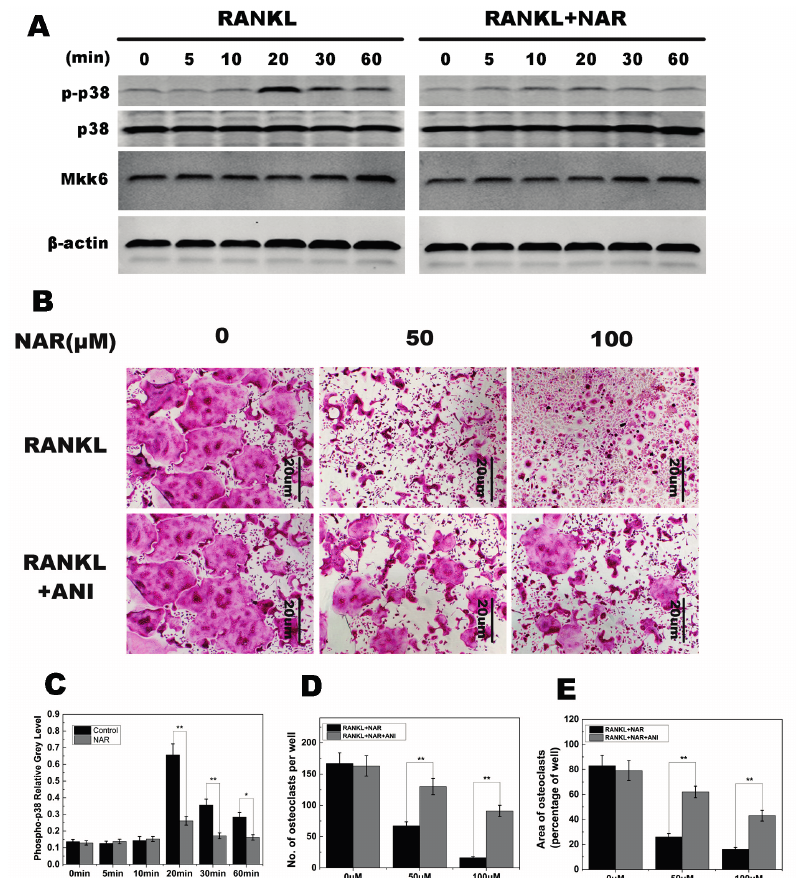
Figure 6. Naringenin (NAR)-mediated suppression of receptor activator of the nuclear factor- κ B ligand (RANKL)-induced effects on p38 signaling. ( A ) p38 phosphorylation was increased within 20–60 min of stimulation with RANKL in the control group, and greatly reduced by treatment with 200 μ M NAR. MAPK kinase 6 (MKK6) was not affected by 200 μ M NAR; ( B ) Anisomycin (ANI) counteracted the inhibitory effect of NAR on osteoclast formation. BMMs were stimulated with 30 ng/mL macrophage colony-stimulating factor (M-CSF), 50 ng/mL RANKL, and the indicated concentrations of NAR. In the rescue groups, cells were also treated with 2.5 ng/mL anisomycin. All treated cells were stained for tartrate-resistant acid phosphatase (TRAP); ( C ) The gray levels corresponding to p38 phosphorylation were quantified and normalized relative to β -actin by using ImageJ software, and the results presented in this graph confirmed the data presented in ( A ); ( D ) The number of TRAP-positive cells; ( E ) The area occupied by TRAP-positive cells. * p < 0.05; ** p <